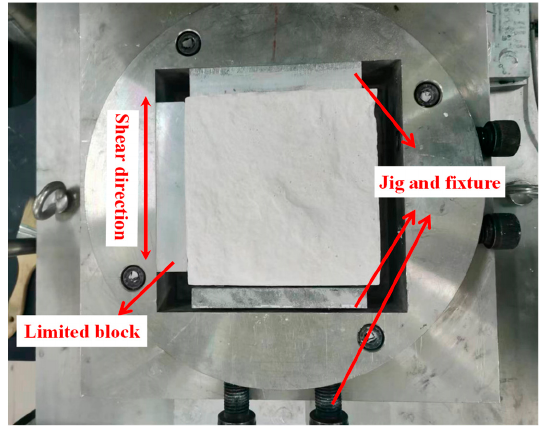
Figure 4. Sample fixed in shear box.